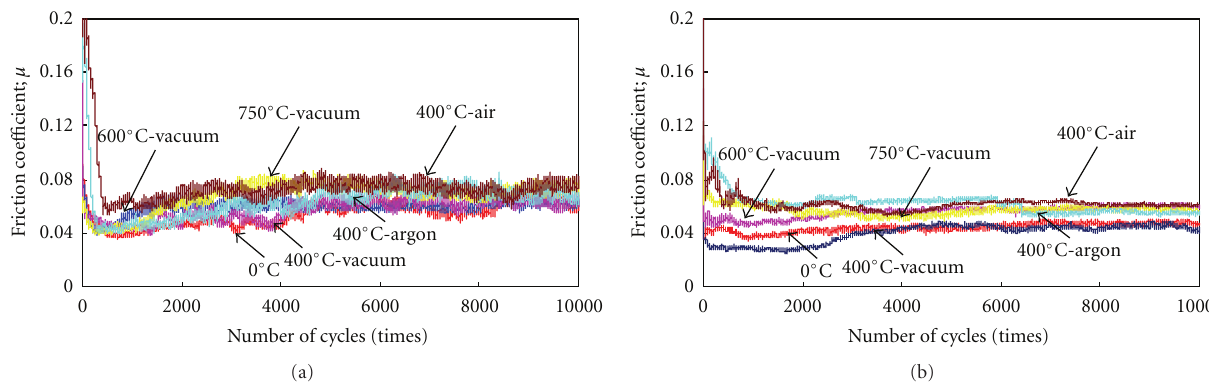
Figure 7: Changes in friction coe ffi cients of DLC-Si–O films before and after annealing at (a) 21 at.%Si (b) 34at.%Si.